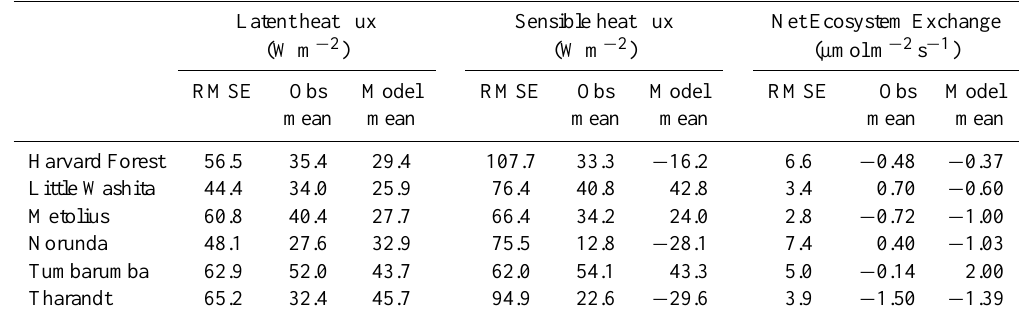
Table 2. Basic data for each flux tower site for the latent heat flux, sensible heat flux and net ecosystem exchange. These figures are derived from 30-min observed and modelled